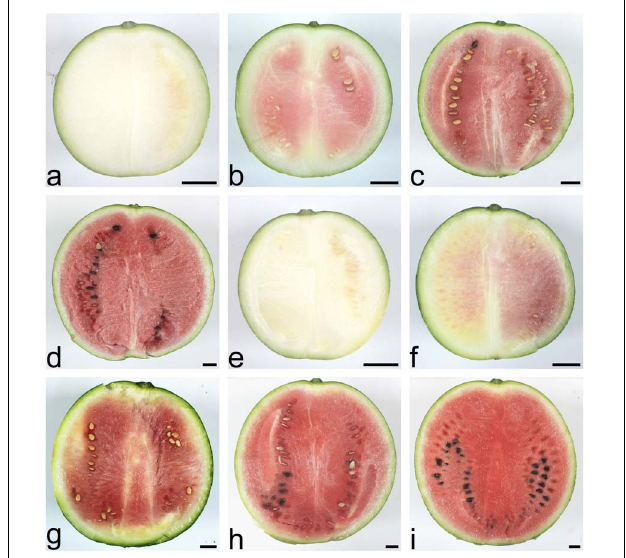
FIGURE 1 | Fruit phenotypes of the watermelon self-grafted (SG) plant and the pumpkin-grafted (PG) plant at different development stages. (a) SG fruit at 10 days after pollination (DAP). (b) SG fruit at 18 DAP. (c) SG fruit at 26 DAP. (d) SG fruit at 34 DAP. (e) PG fruit at 10 DAP. (f) PG fruit at 18 DAP. (g) PG fruit at 26 DAP. (h) PG fruit at 34 DAP. (i) PG fruit at 40 DAP. Scale bar, 2